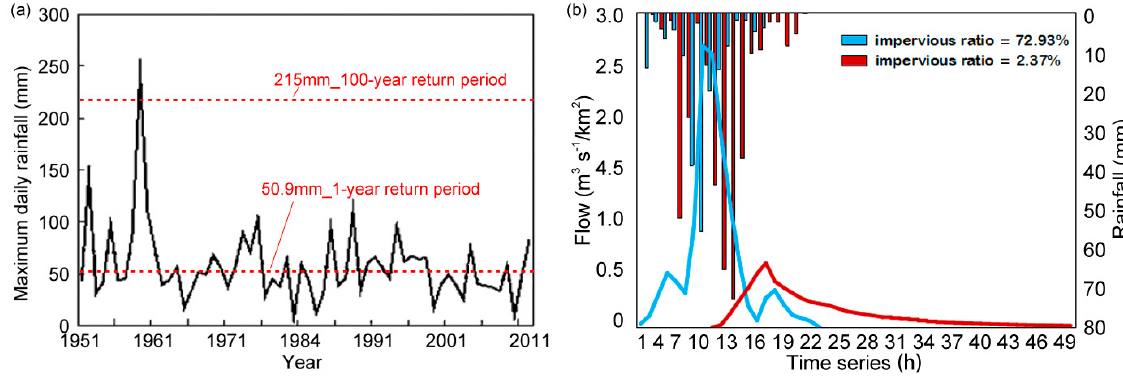
Figure 2. Characteristics of ( a ) maximum daily rainfall in July in Beijing and ( b ) hydrographs of river runoff with different degrees of urbanization.